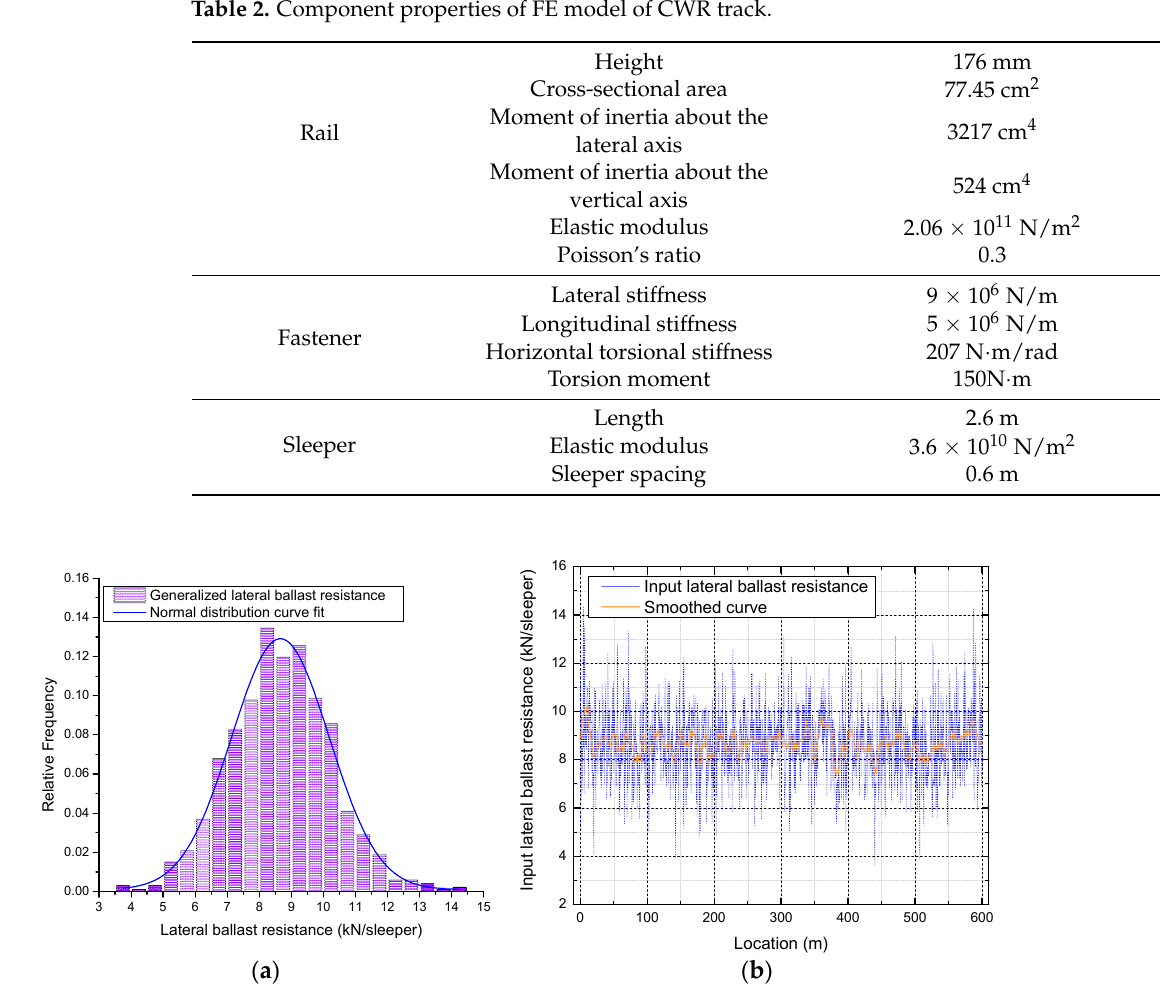
Figure 8. FE model of CWR track ( a ) Whole model; ( b )FE model details of CWR track. Table 2. Component properties of FE model of CWR track.